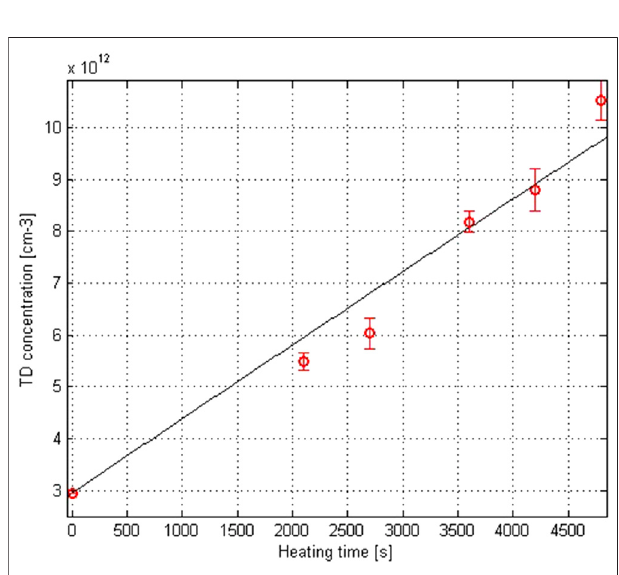
FIGURE4| EvolutionofTDformationinhigh-resistivityp-typeMCz-Sias a function of annealing time at 430 °